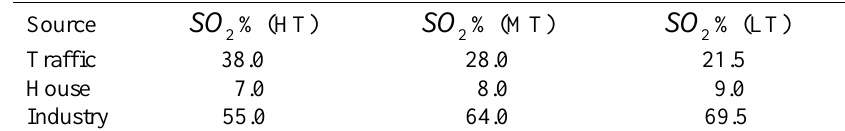
S O percent share for sub-groups in the GTA,2008 2 Source